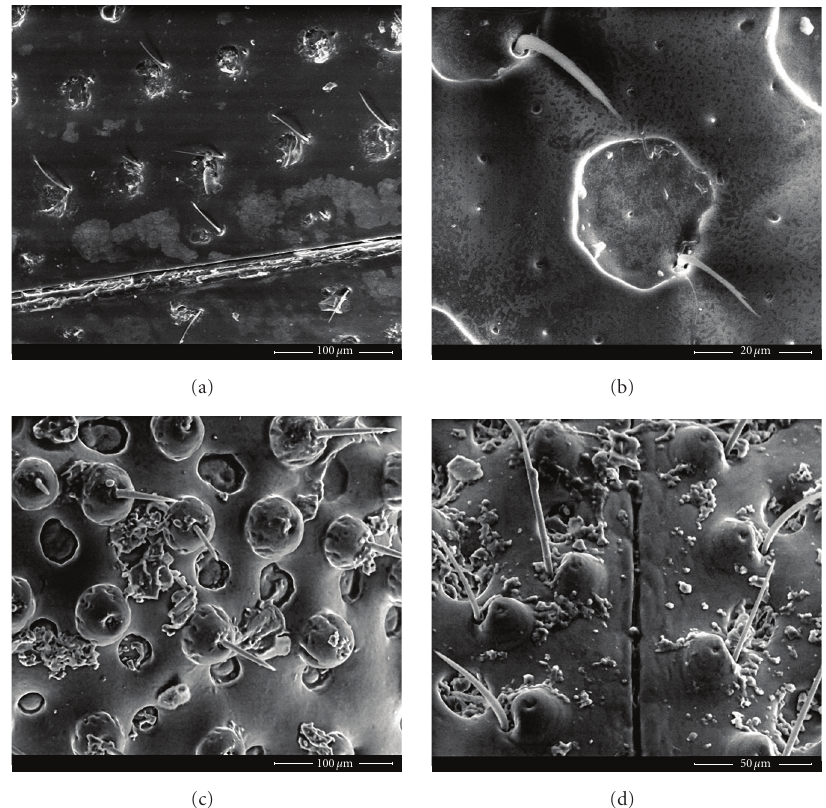
Figure 2: Insertions of hair. (a) Rhyzopertha dominica (Fabricius, 1792), (b) D. minutus , (c) declivity of Stephanopachys rugosus , (d) declivity of Stephanopachys substriatus